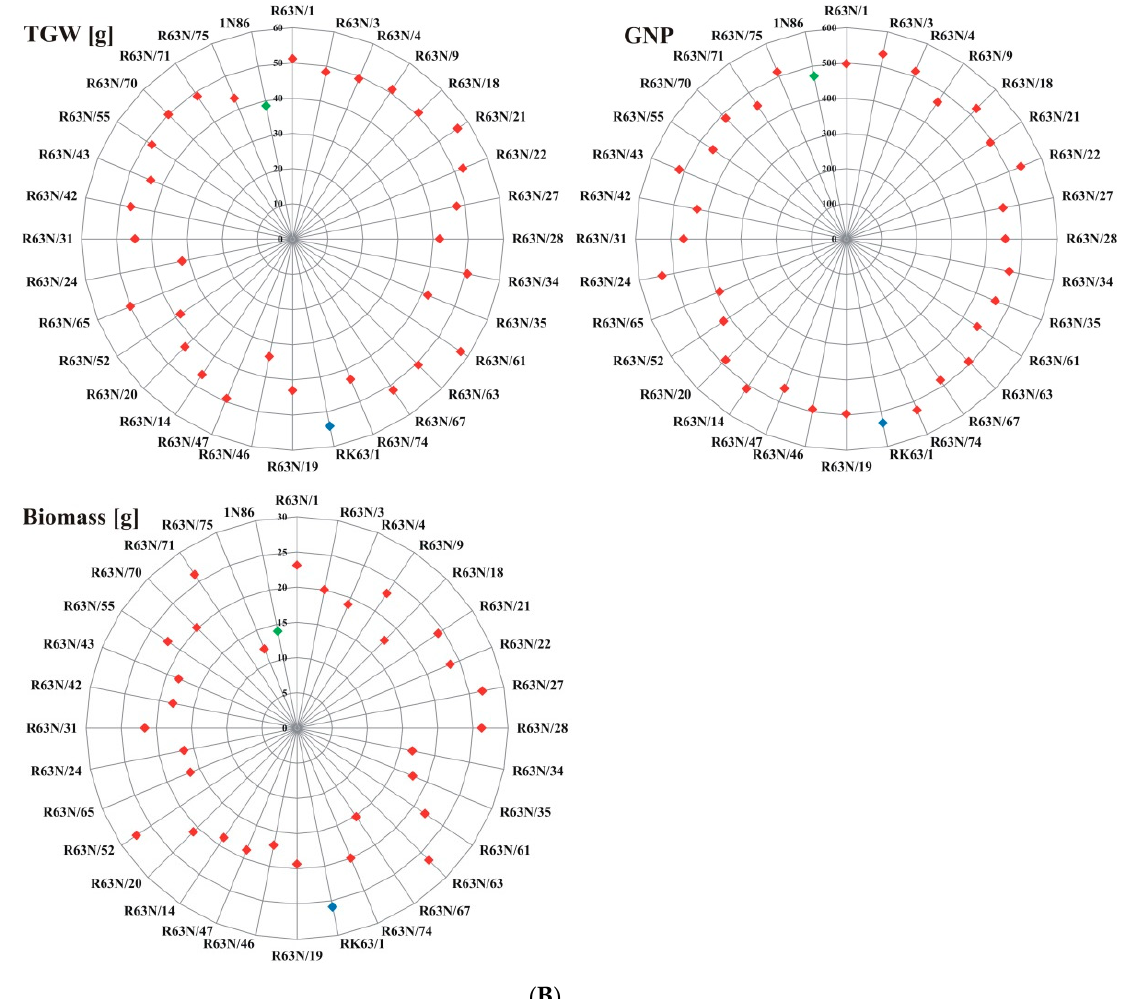
Figure 1. Average values of the studied chlorophyll fluorescence indices ( A ), yield elements and biomass ( B ) for the set of 32 barley DH lines (blue—hulled parental form, green—hull-less parental form, red—offspring DH lines).